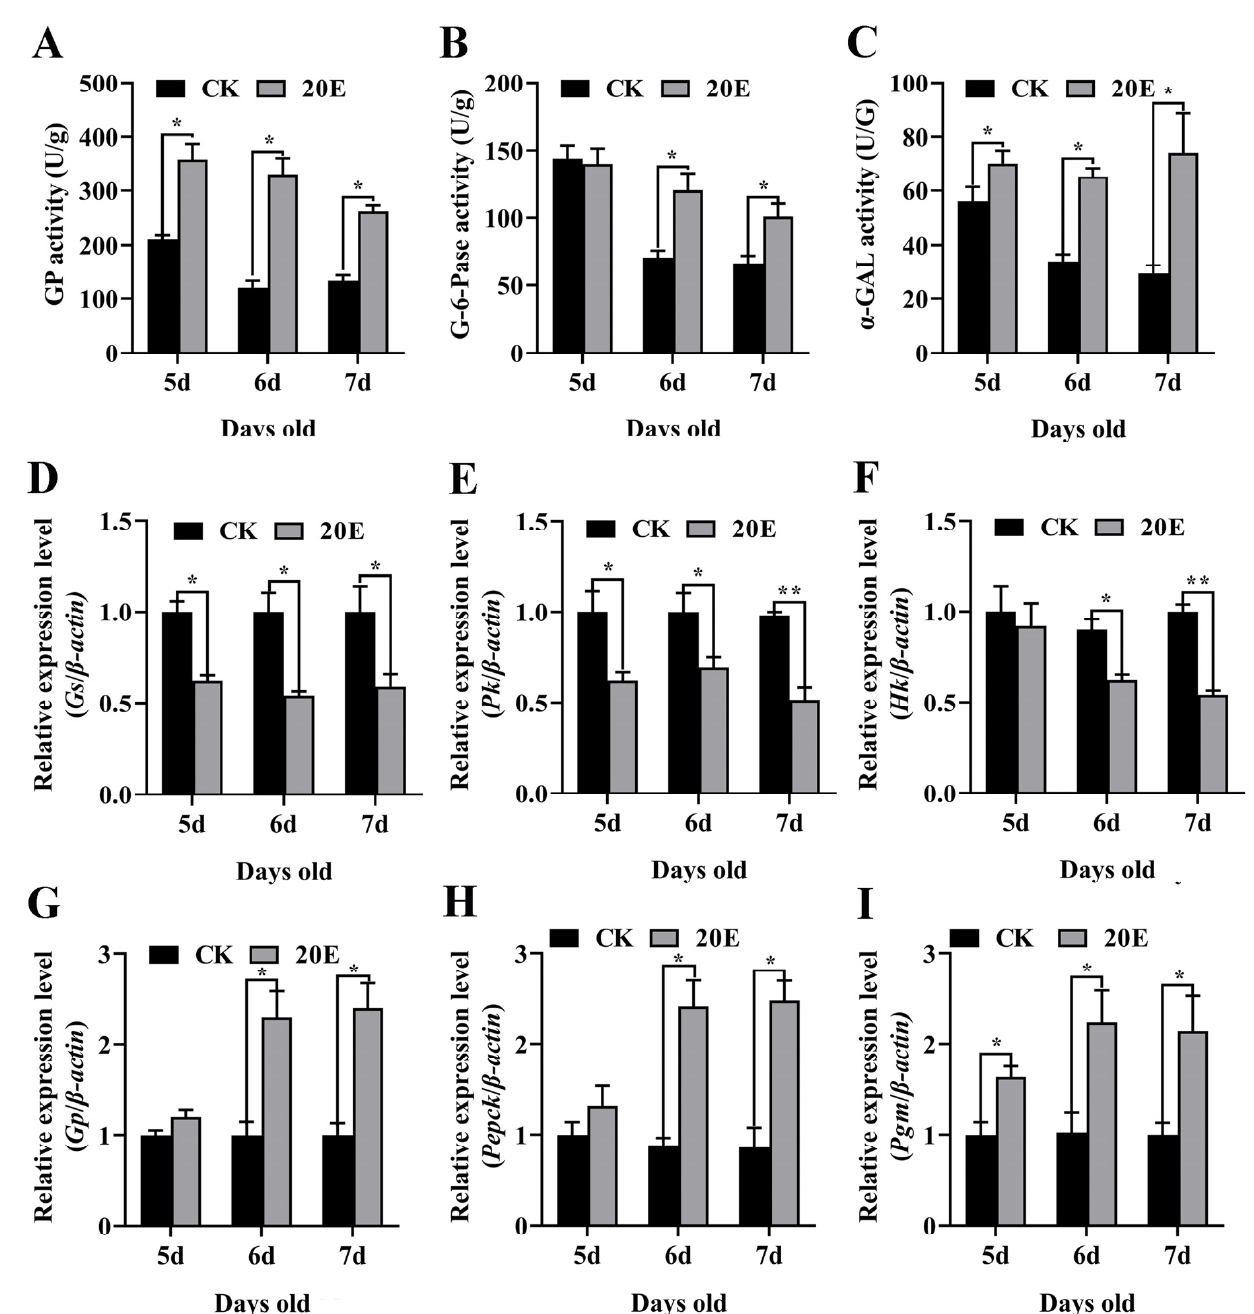
Figure 8. Variation in GP, G-6-Pase and α -GAL activity and related gene expression levels after 20E treatment. ( A ) The hemolymph GP activity during development; ( B ) the hemolymph G-6-Pase activity during development; ( C ) the hemolymph α -GAL activity during development. Bee Ringer solution was used as the solvent control. ( D – I ) qRT-PCR showing the mRNA expression levels of Gs , Pk , Hk , Gp , Pepck and Pgm after 20E treatment. The error bars indicate the mean ± SEM of three times repetition. The asterisks indicate significant differences from the control group (*, p < 0.05; **, p < 0.001) by using the Student’s t- test.